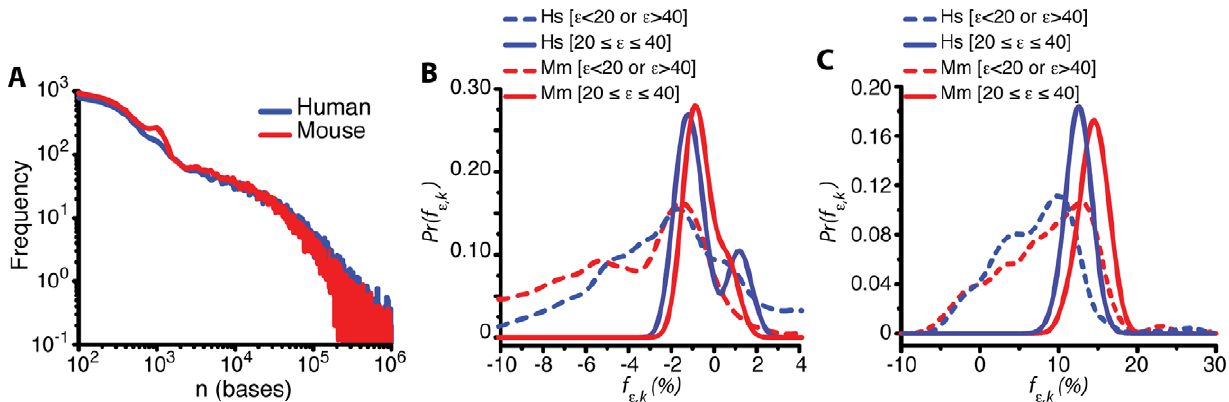
Figure 7. A. Distribution of transcript lengths based on the annotations (Materials and Methods). Mean values: 69900 bp (human) and 58300 bp (mouse); median values: 26209 bp (human) and 16972 bp (mouse). B . Distribution of FENAS values ( f e ,k (%)) for human (red) and mouse (blue). The distributions are separately shown for those exon around the theoretically predicted optimum ( 20 ƒ e ƒ 40 , solid lines) or those exons that are far from n opt ( e v 20 or e w 40 , dashed lines). These distributions were constructed by considering all the values of f e ,k all the tissues (data pooled over k ). The distribution of FENAS values for e close to n opt was significantly different from the distribution of FENAS values for e far from n opt both for human and mouse (t-test, p , 0.05). C . Same as part B but using RNAseq data.